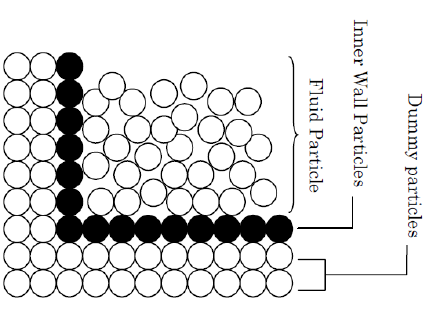
Fig. 4: Dummy boundary